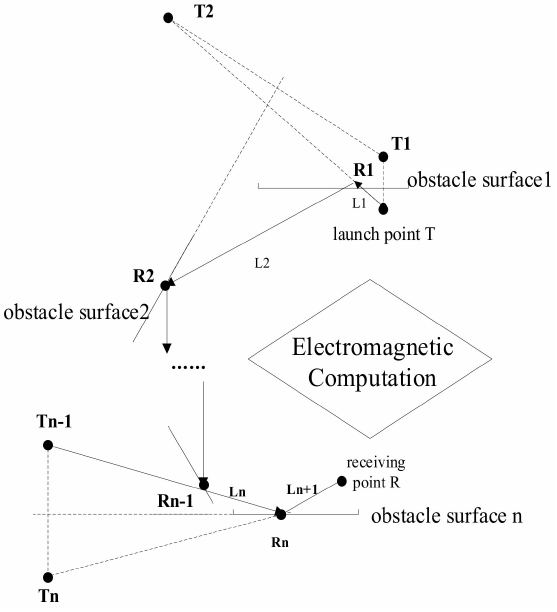
Figure 4. Mirror ray propagation